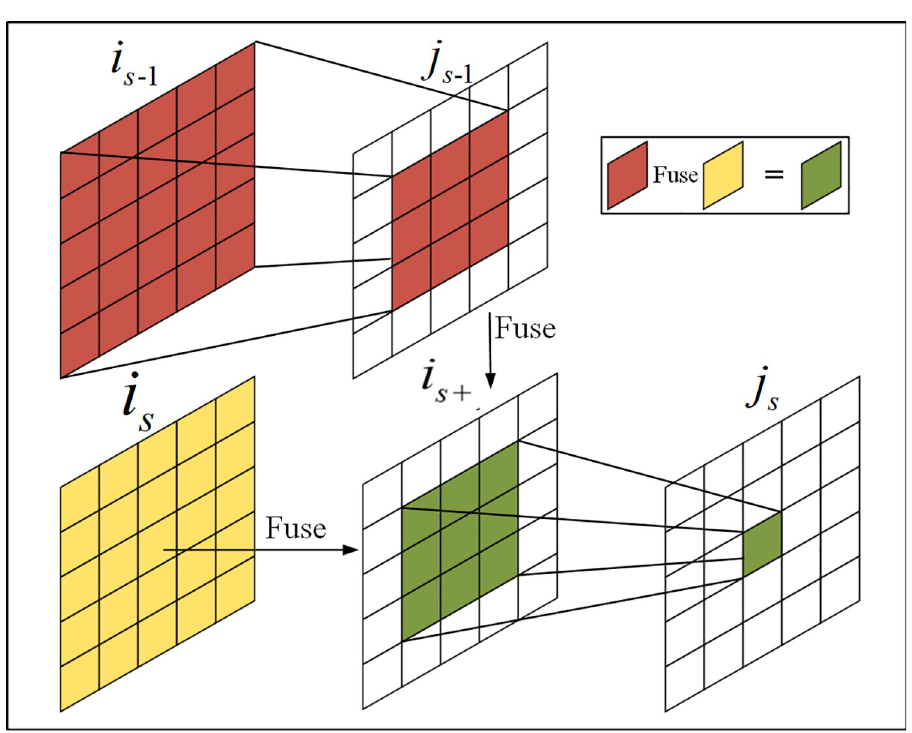
Fig 4. Extended visual field of receptive